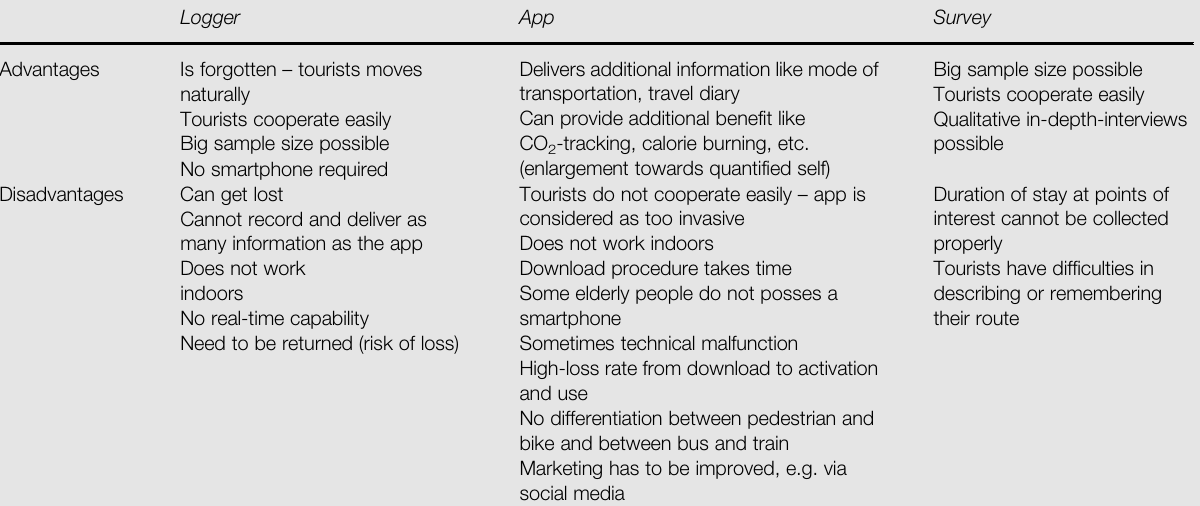
Table I Advantages and disadvantages of approaches in tourist tracking